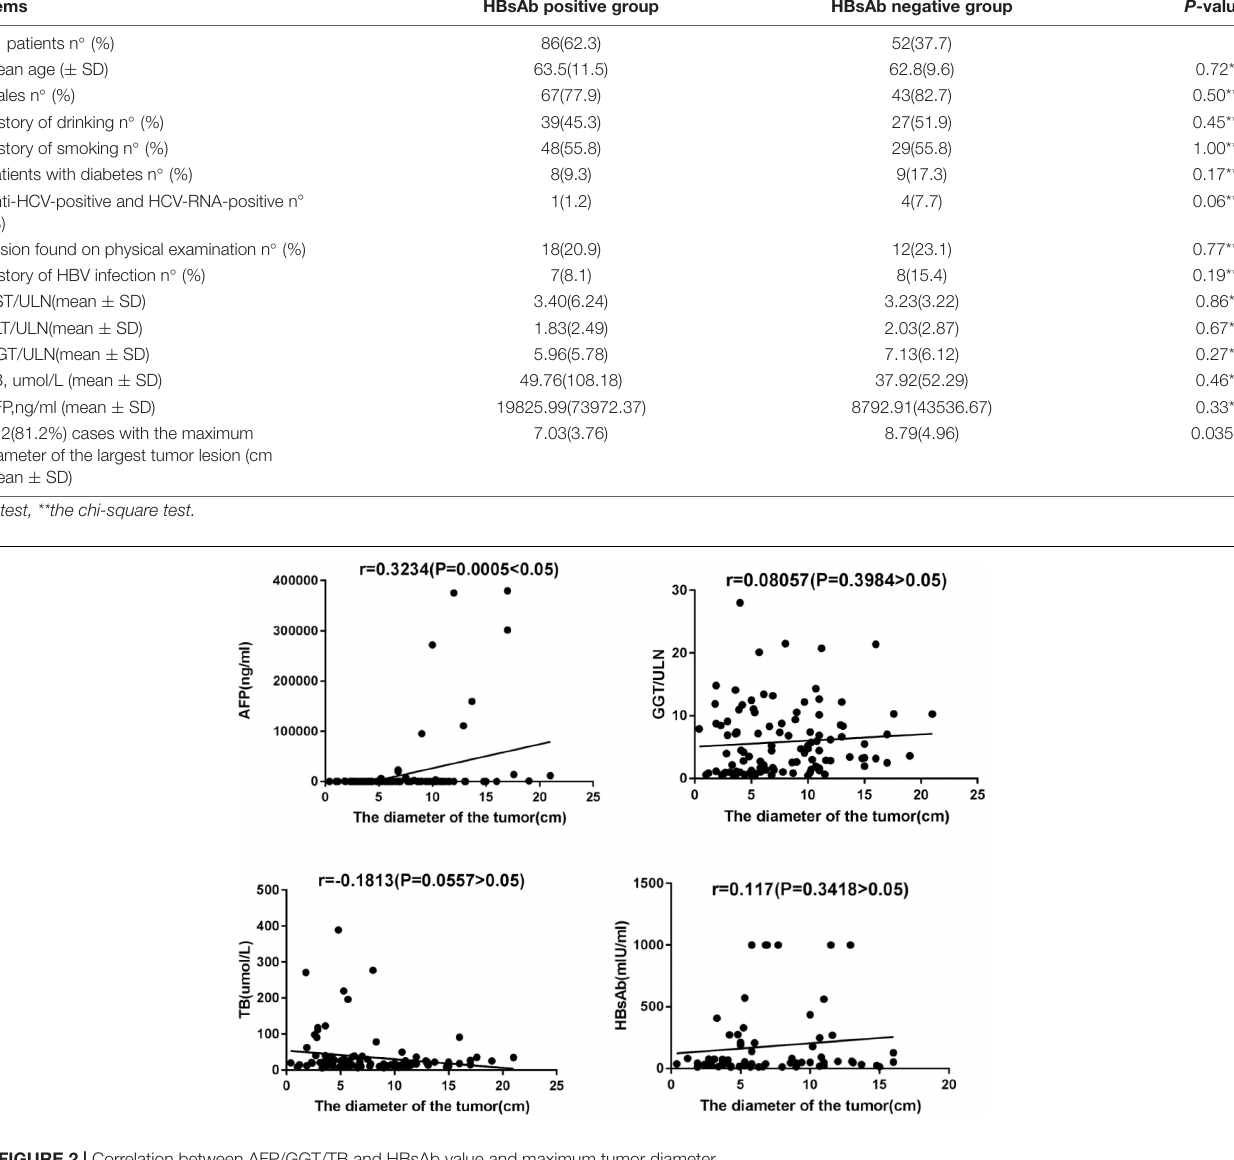
FIGURE 2 | Correlation between AFP/GGT/TB and HBsAb value and maximum tumor diameter.